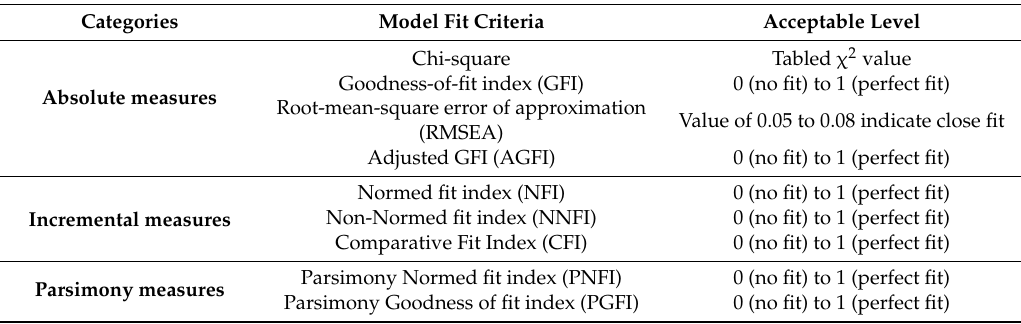
Table 9. GOF measures used for the analysis.